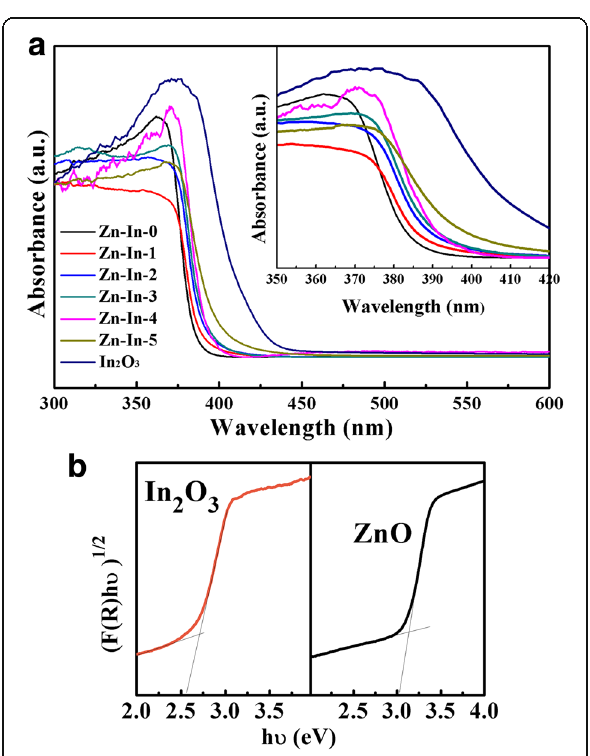
Fig. 5 a UV-vis diffuse reflectance spectra of the prepared composites and b band gap energy of pure ZnO and In 2 O 3 samples